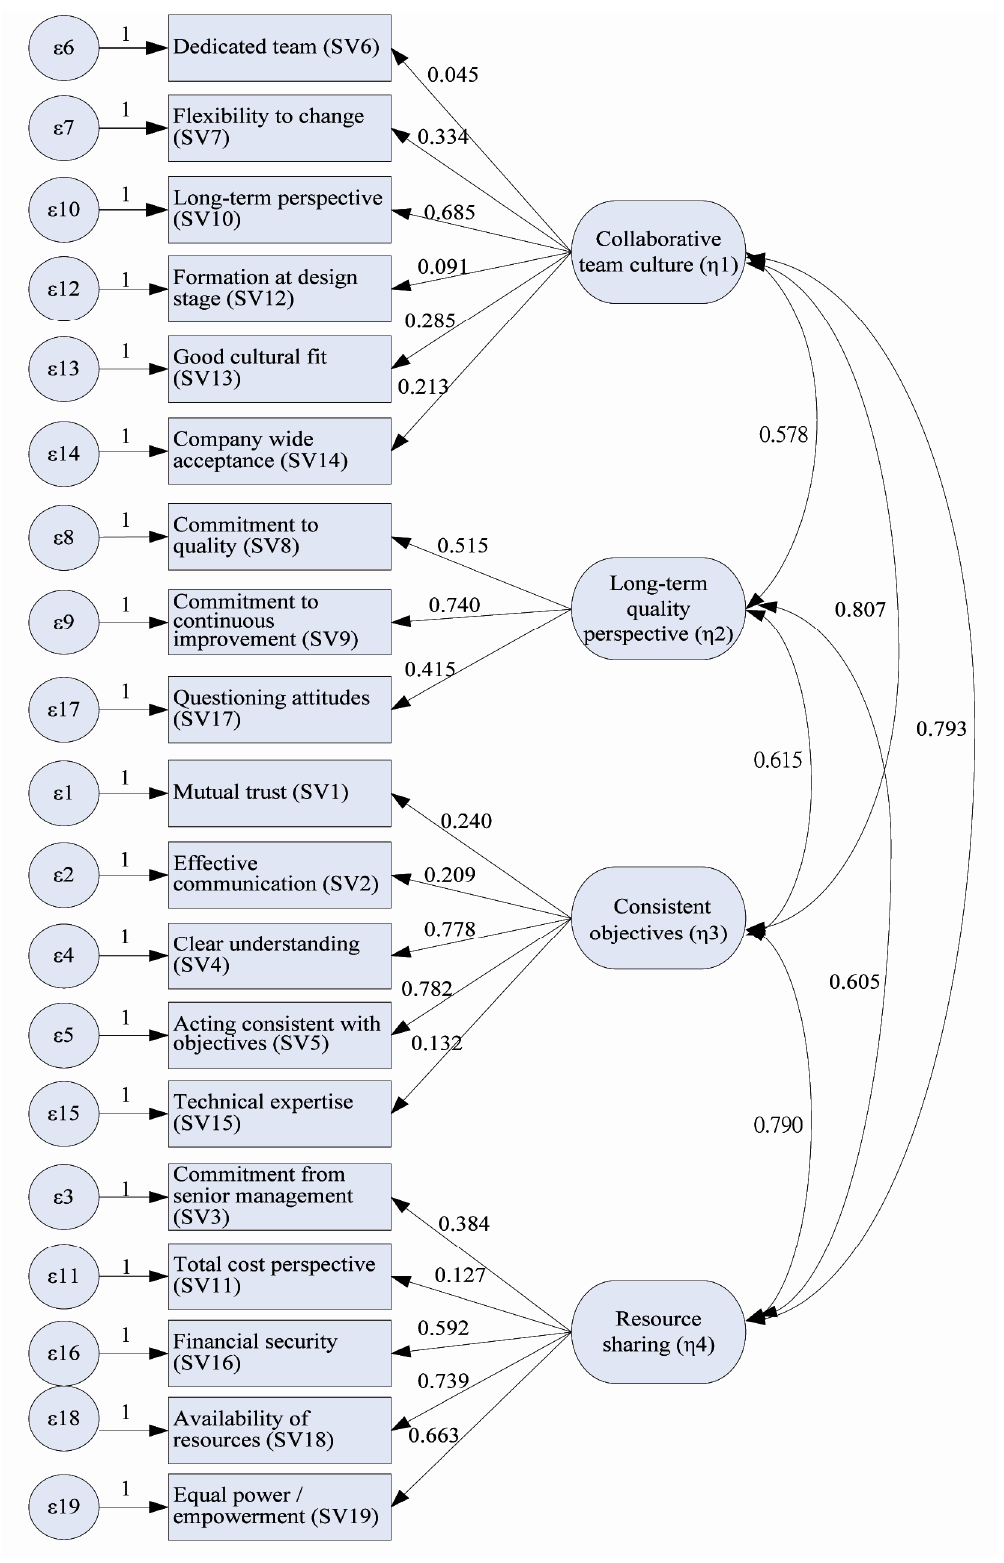
Fig. 1. Initial SEM framework with